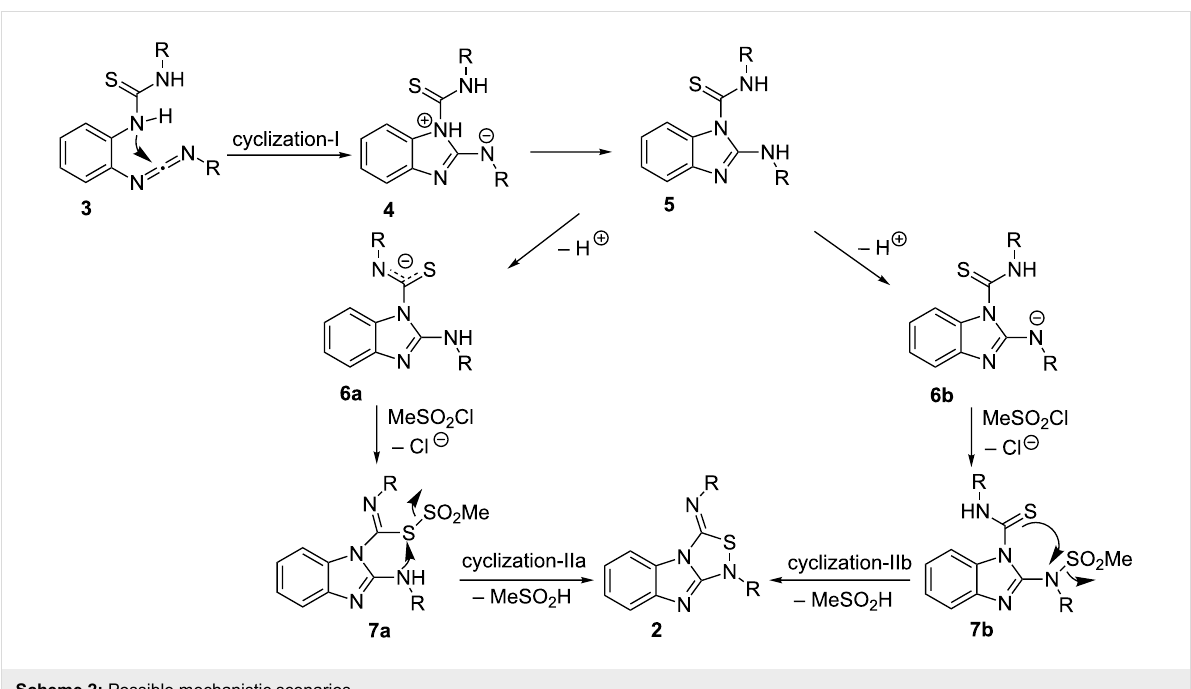
Scheme 2: Possible mechanistic